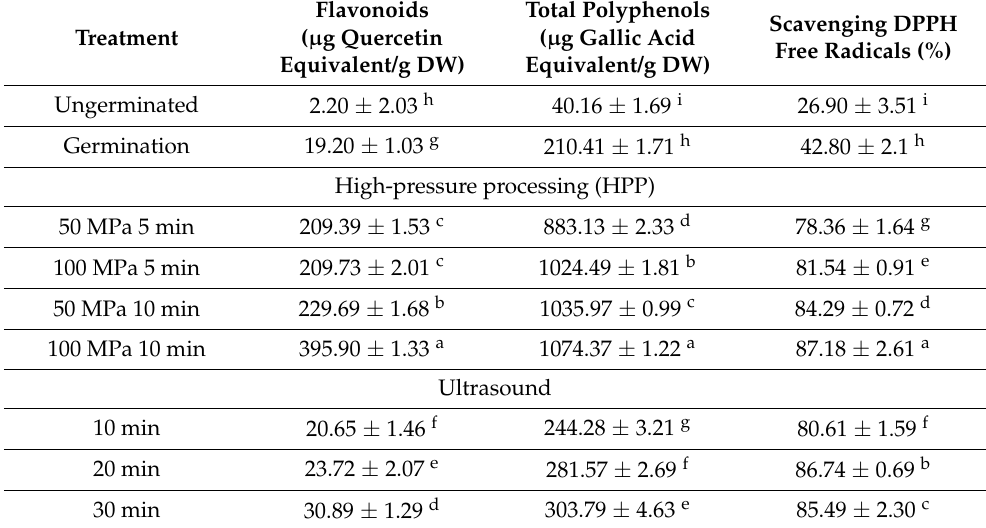
Table 5. Effects of HPP and ultrasound on the content of antioxidant active components in germinated